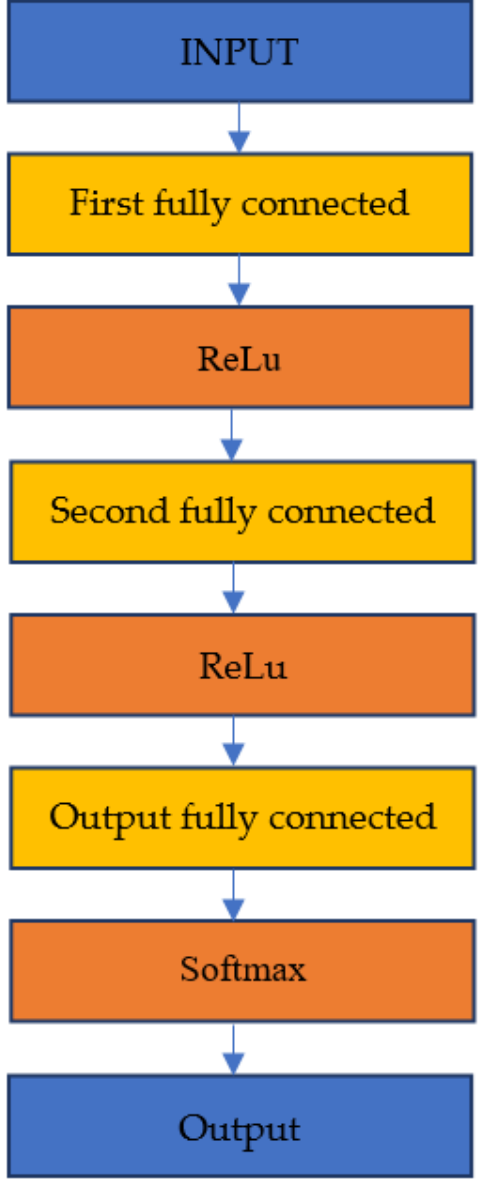
Figure 18. Neural network training process.